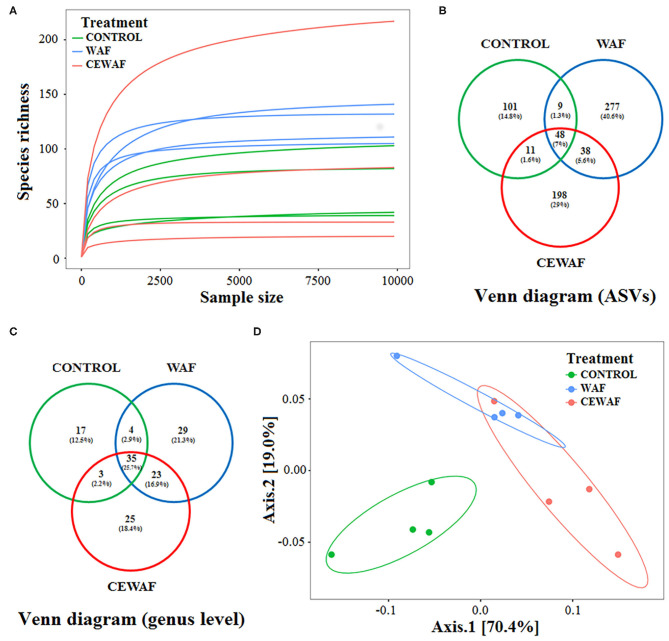
Main statistics of biodiversity analysis. (A) Rarefaction curves of ASVs. (B,C) Venn diagram of the ASVs that are shared among the groups. (D) UniFrac PCoA plot showing the separation among sample groups exposed to WAF (blue dots) and CEWAF (orange dots) respect to CONTROL (green dots) group.